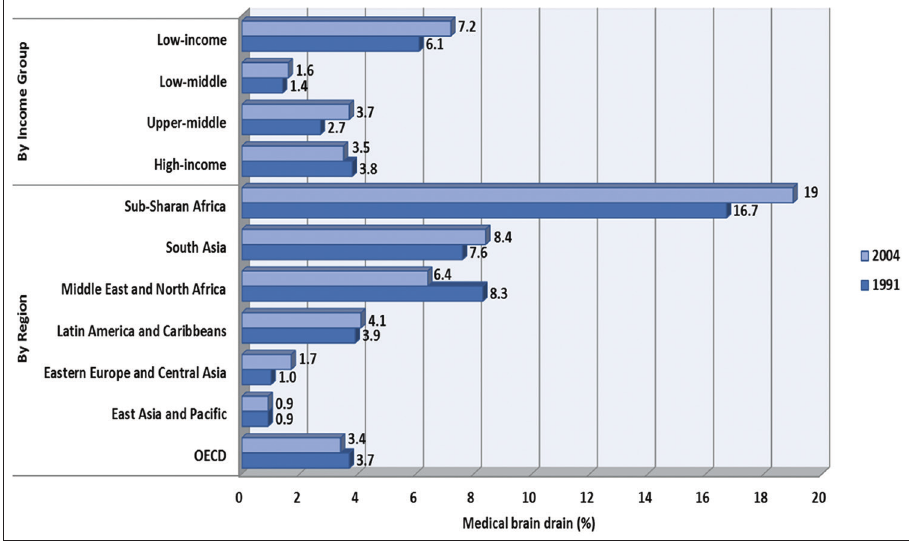
Figure 1 : Medical brain drain by region and income group in 1991 and 2004, data source. [2] Note: Medical brain drain is defined as the proportion of physicians trained in their country but employed abroad